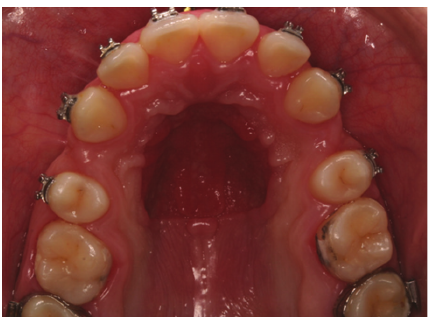
Figure 1: This photograph shows inaccuracies in the support structure due to a Nance button anchorage reinforcement appliance used for a long